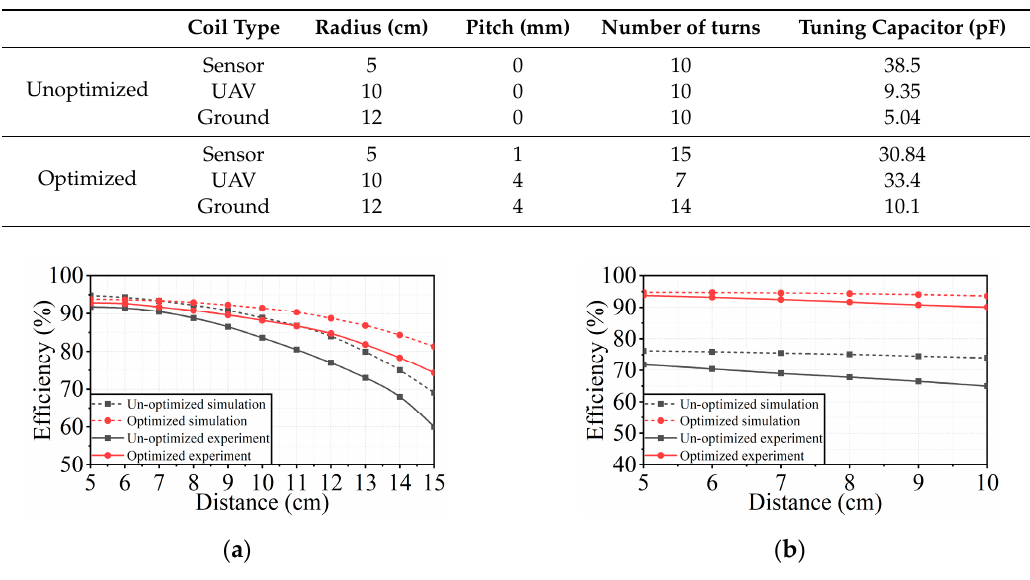
Figure 18. Comparison between simulation and experimental results: ( a ) UAV to sensor; ( b ) ground transmitting side to UAV.